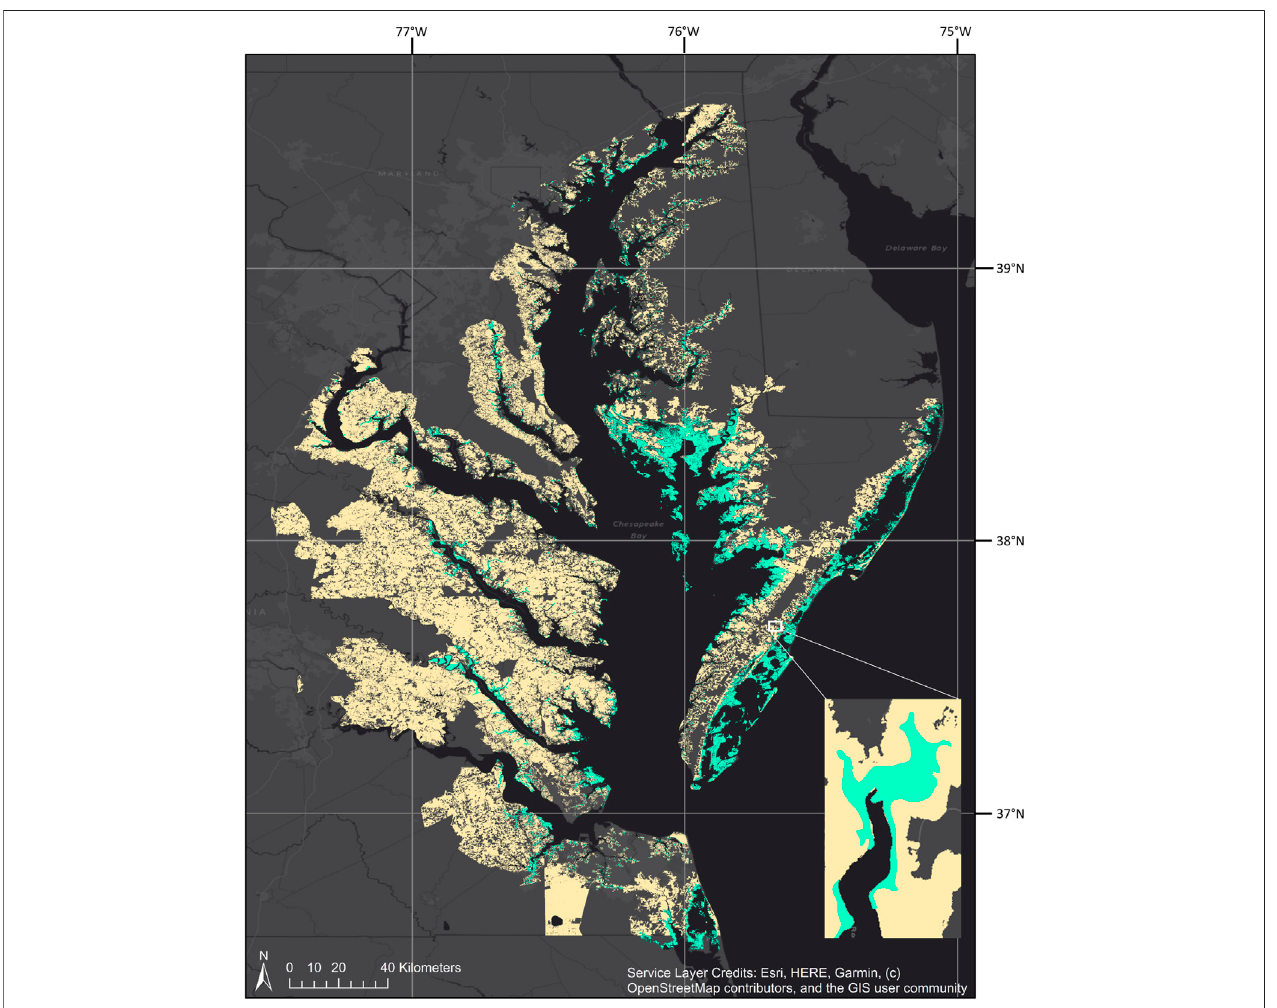
FIGURE 1 | Study area with the NWI estuarine intertidal emergent wetlands in teal and forest extent obtained from Chesapeake Conservancy Land Use and Land Cover datasets in tan. Inset has been rotated 90 ° clockwise from actual position and is the same location as Figure 2 .